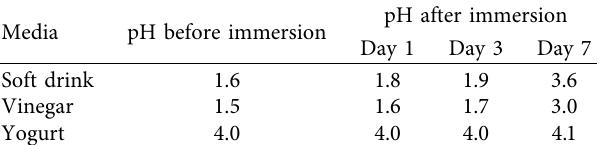
Table 1: Changes in the pH of the medium before and after immersion of the dentin sample.